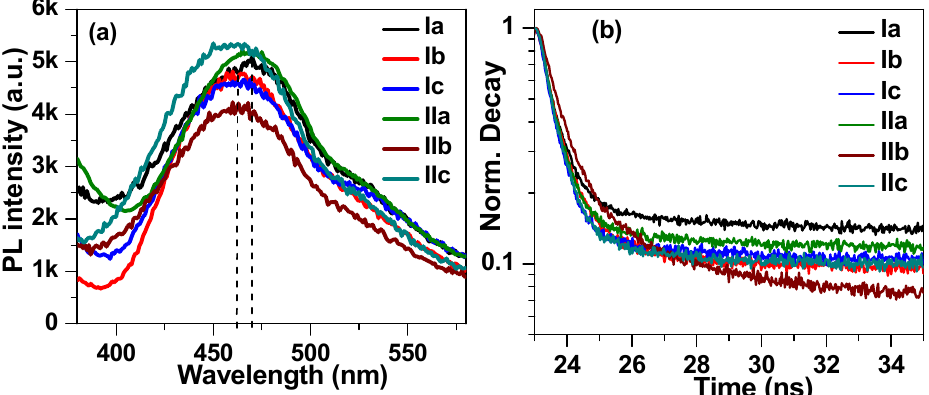
Figure 10. ( a ) Steady-state photoluminescence and ( b ) time-resolved fluorescence spectra of liquid crystalline material.